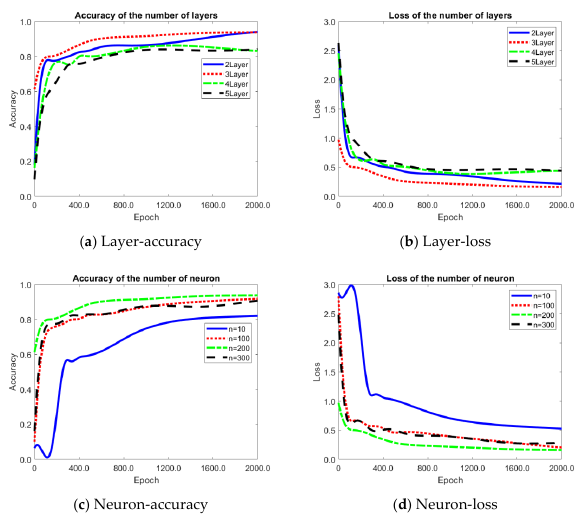
Figure 8. Performance test for the number of hyperparameters.